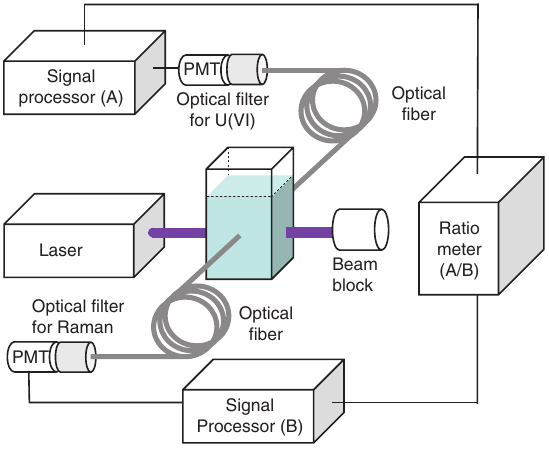
Figure 9 Proposed schematic diagram of the experimental setup for the ratiometric